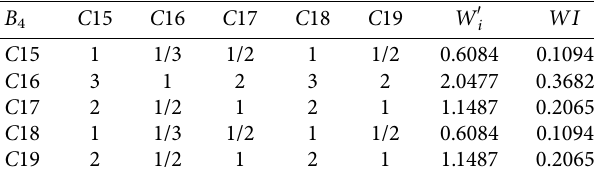
Table 6: B 4- C judgment